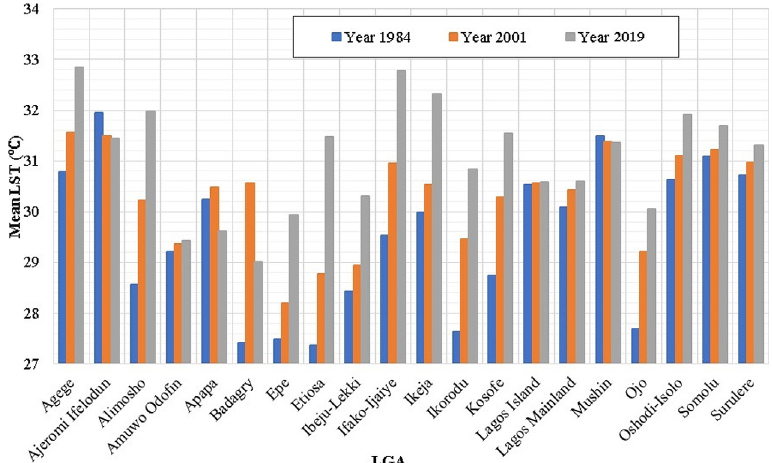
Fig. 6. Distribution of mean